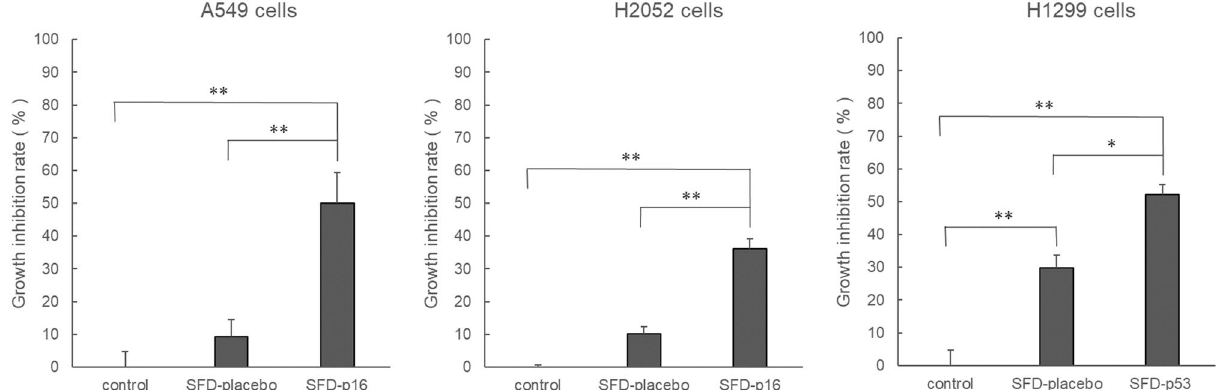
Figure 2. Cell growth inhibition rate of each cell line 24 h after inhalable gene transfection. Significant growth inhibition by inhalable gene drugs (SFD-p16 or SFD-p53) was observed in all cell lines. The results were analyzed using a one-way ANOVA followed by Bonferroni multiple comparisons tests. The data represents the means ± SD of the percentage (0% = cell inhibition rate of control). N = 3, ** p < 0.01, * p < 0.05.